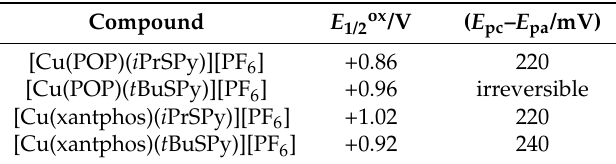
Table 1. Cyclic voltammetry data for [Cu(P^P)(N^S)][PF 6 ] complexes in CH 2 Cl 2 (1–5 × 10 − 3 M, vs.